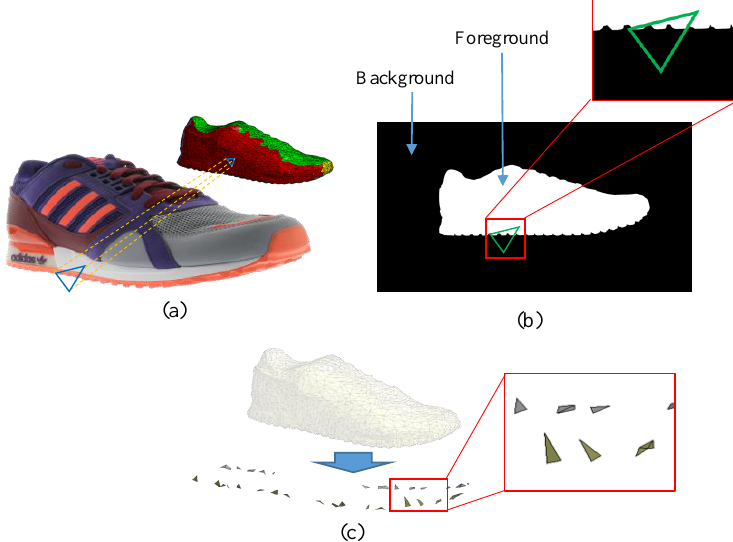
Figure 8. Detection and removal of meshes with missing color: ( a ) the projected mesh outside the image silhouette, ( b ) the image converted into foreground (white) and background (black) in accordance with the alpha channel, and ( c ) meshes detected outside the image silhouette.